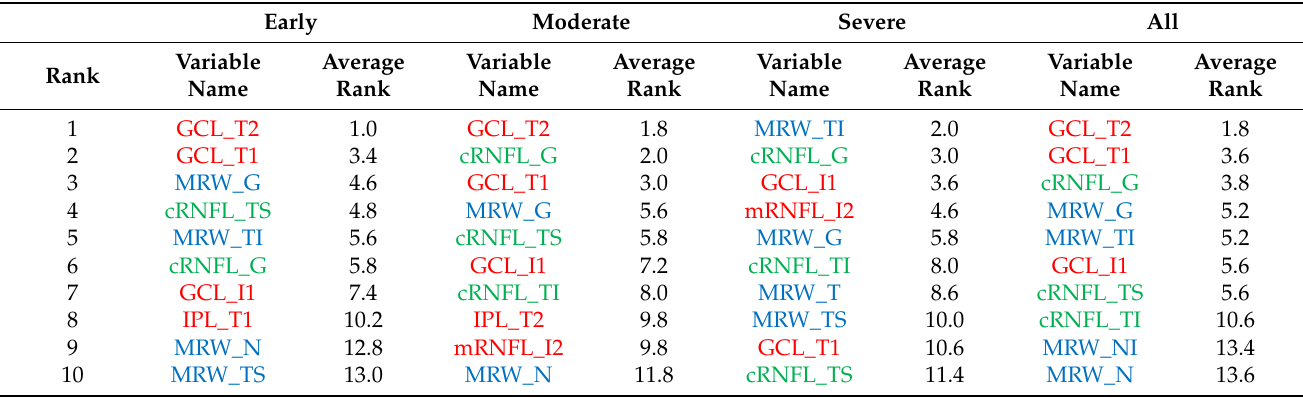
Table 6. Overall variable importance ranking for early, moderate, severe, and all glaucoma eyes (only the first 10 important variables